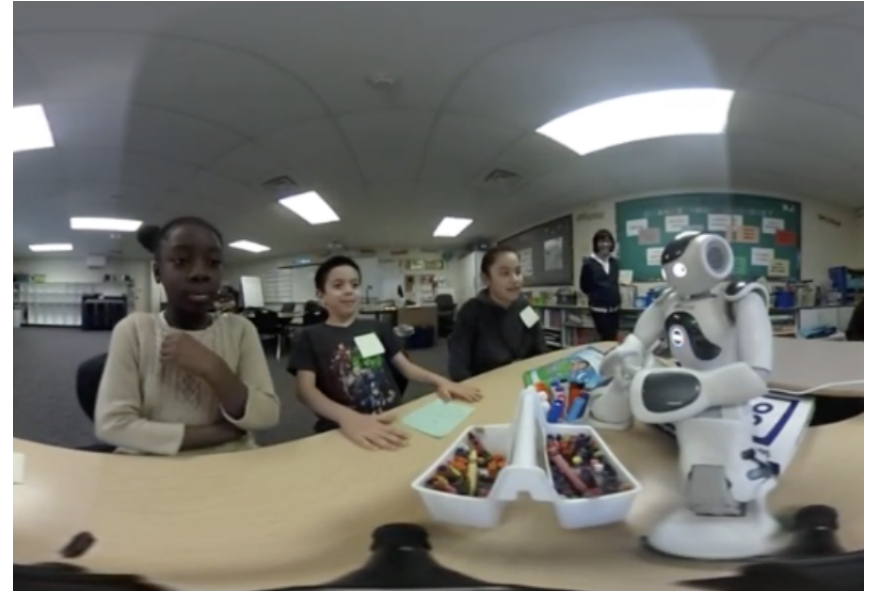
Figure 4. In this image, the three students are facing the social robot and one girl stares at the robot and appears shocked or frightened with her arm across her